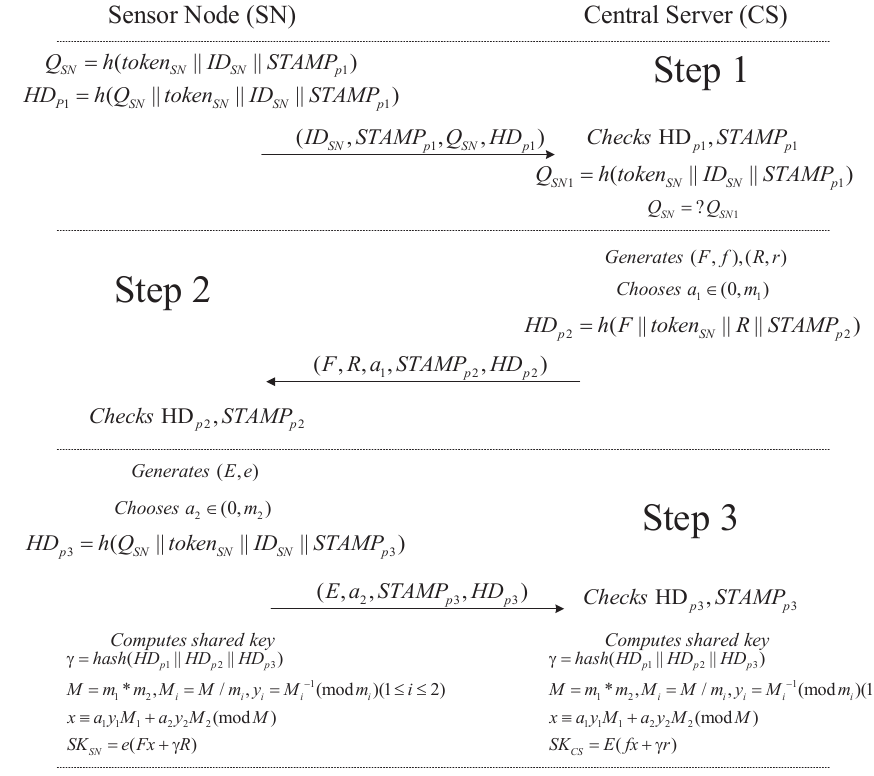
Figure 2. The key agreement protocol between the sensor node and the central